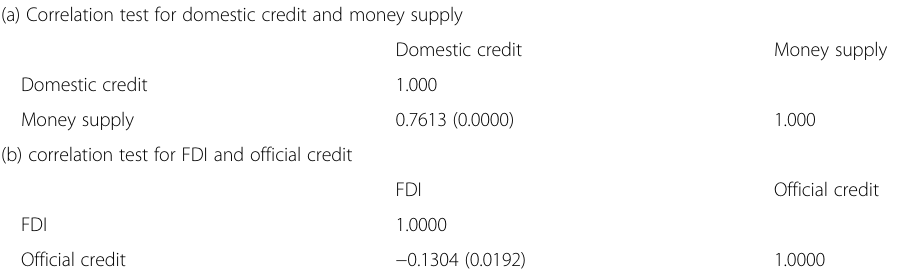
Table 7 Correlation tests for foreign capital inflows and financial development ’ s proxies (a) Correlation test for domestic credit and money